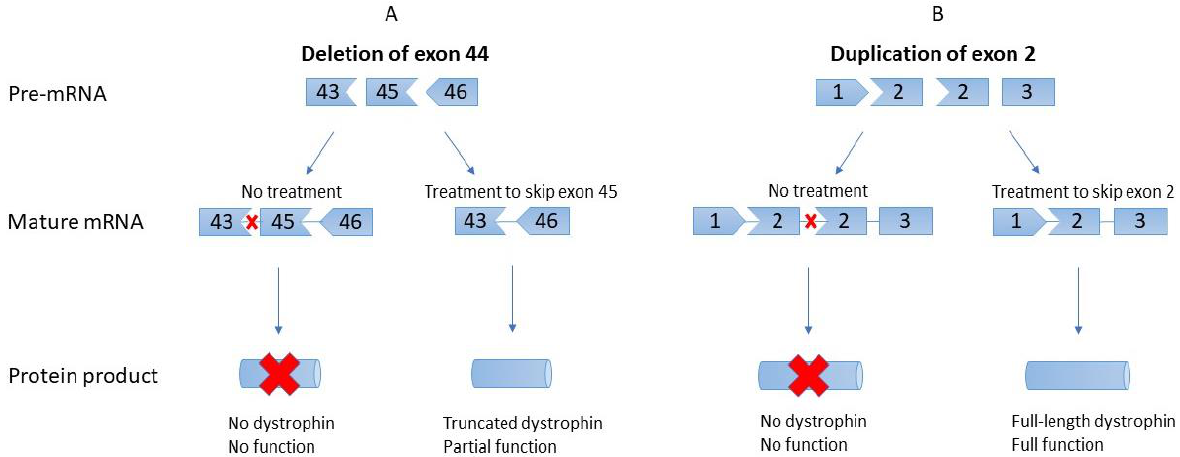
Figure 1. Differences in exon skipping for deletions compared to duplications. ( A ). Deletions, such as the pictured deletion of exon 44, require skipping of an adjacent exon to restore proper reading frame, in this case exon 45. The resulting product is an internally deleted but functional dystrophin product. ( B ). In contrast, duplications require the direct skipping of the duplicated exon, resulting in the return of normal, full-length dystrophin with normal function. In this case, the duplicate of exon 2 is skipped to restore the healthy transcript.